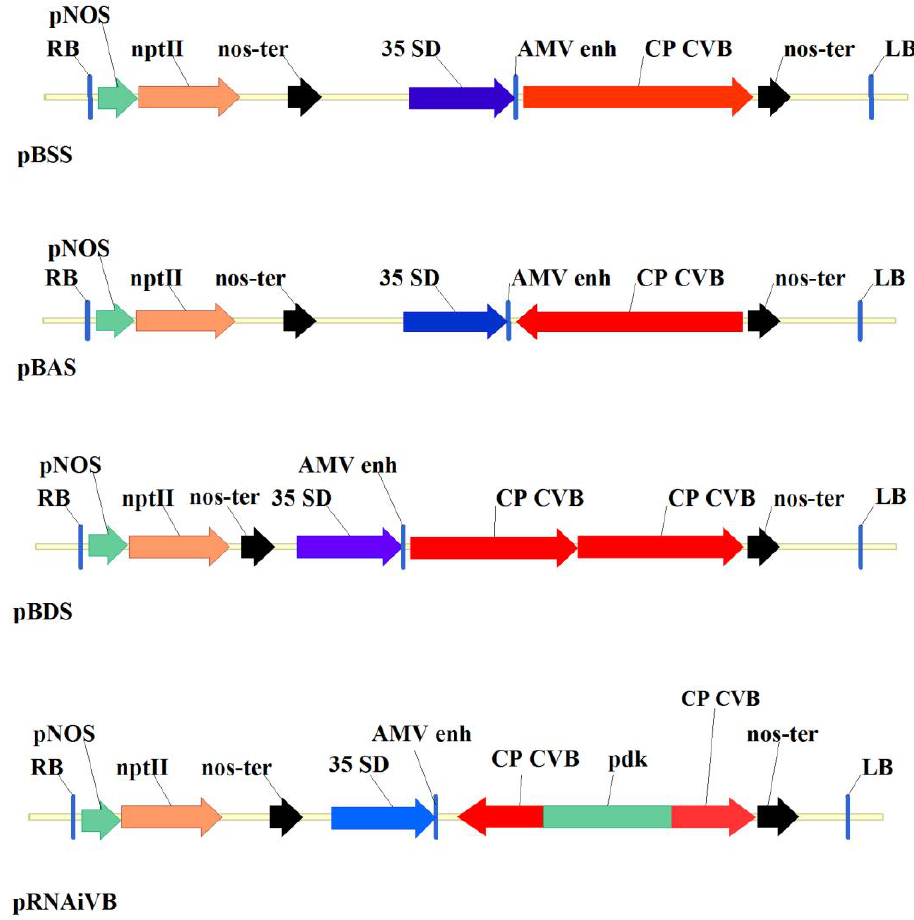
Figure 1. The expression cassettes structure of used transformation vectors. RB and LB—right and the left borders of T-DNA; pNOS—nopaline synthase promoter, nos-ter—nopaline synthase terminator; nptII—neomycin phosphotransferase II gene; 35SD—double 35S promoter of cauliflower mosaic virus; AMV enh—enhancer element from the alfalfa mosaic virus; CP CVB—chrysanthemum virus B coat protein gene (or its 296 bp fragment in the pRNAIVB vector); pdk—intron of pyruvate-orthophosphate-dikinase gene from Flaveriatrinervia Flaveria trinervia (Sprengel) C. Mohr .